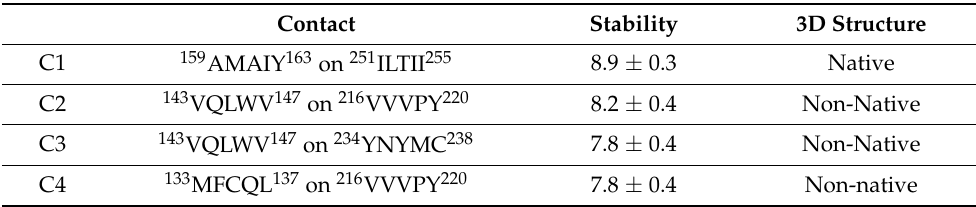
Table 1. Possible primary contacts for the core domain of core p53, their stabilization energy ( k T), and their location in the native 3D